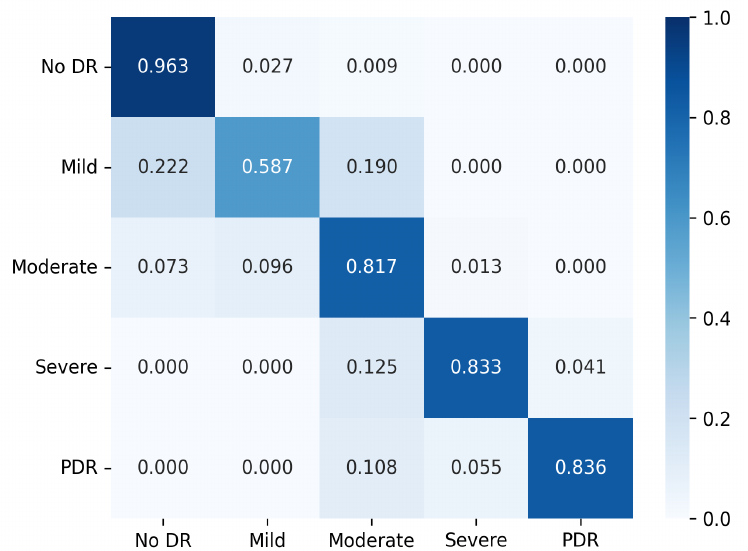
Figure 5. Confusion matrix for the presented method on DDR dataset with normalization